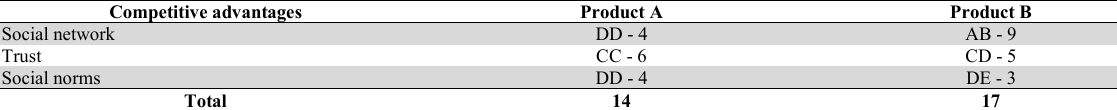
The results of competitive advantages assessment Competitive advantages Product A